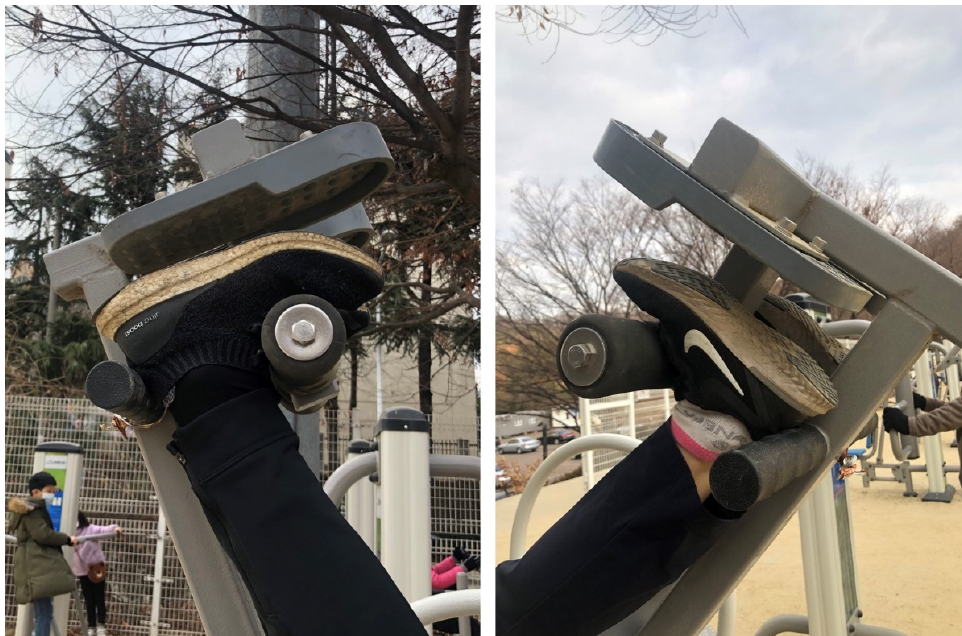
Figure 3. Single-pin ankle lock design is commonly found in public devices.